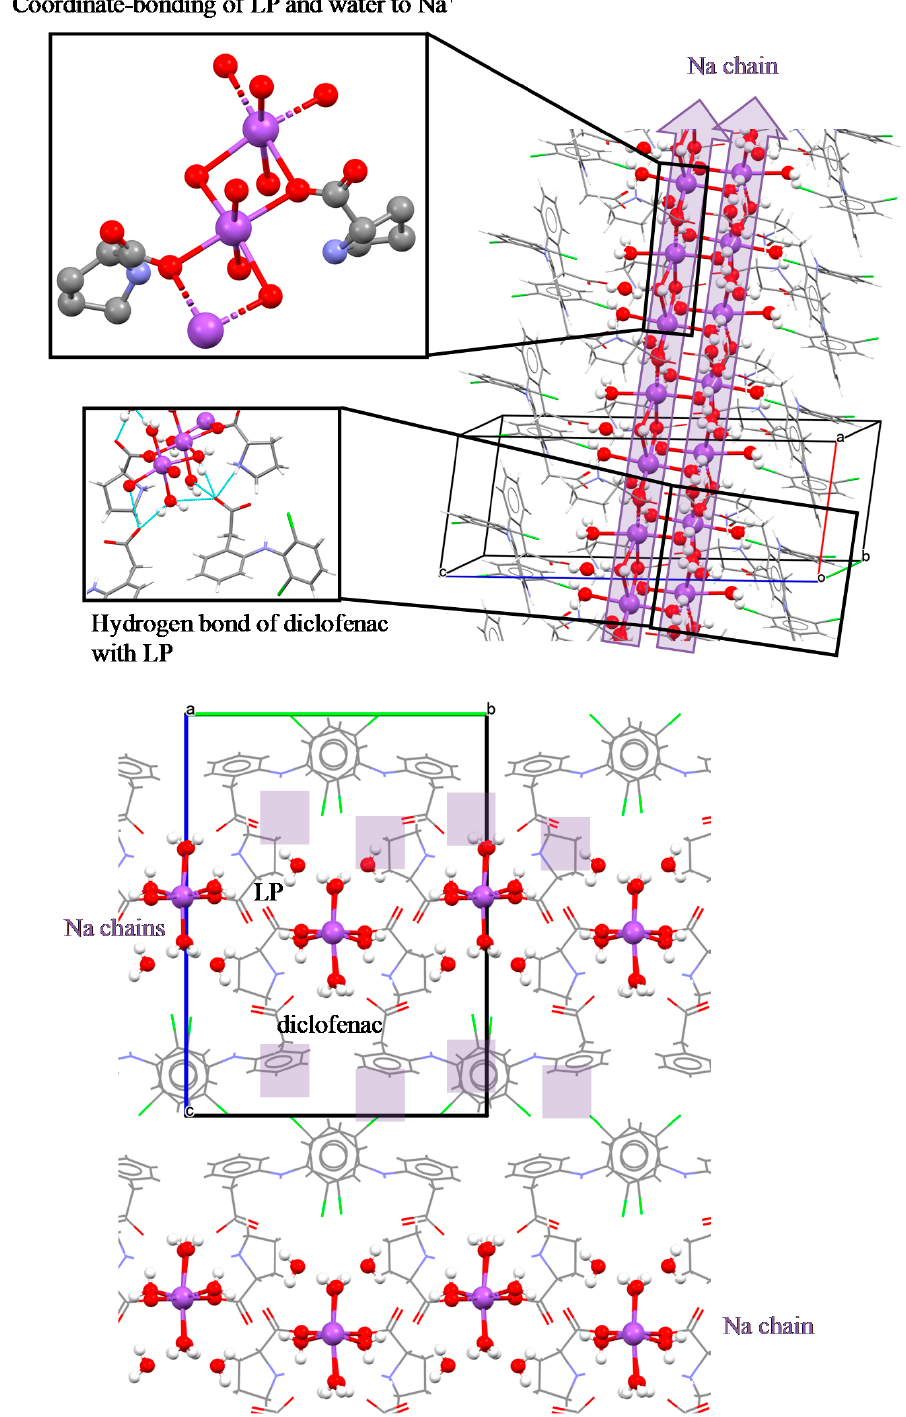
Figure 8. The Na chain structure in NDPT (diclofenac–sodium–proline–tetrahydrate), Na + is in violet.